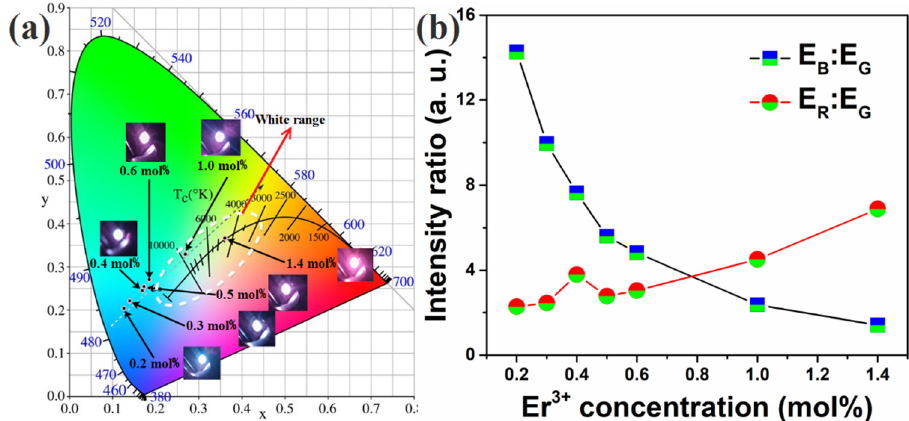
Figure 5. ( a ) CIE chromaticity coordinates for Y 2 O 3 -ZnO: Yb 3+ /Er 3+ /Tm 3+ nano-phosphors under 1.0 W-980 nm diode laser excitation with different Er 3+ doping concentrations. ( b ) The intensity ratios of blue emission to green emission and red emission to green emission.